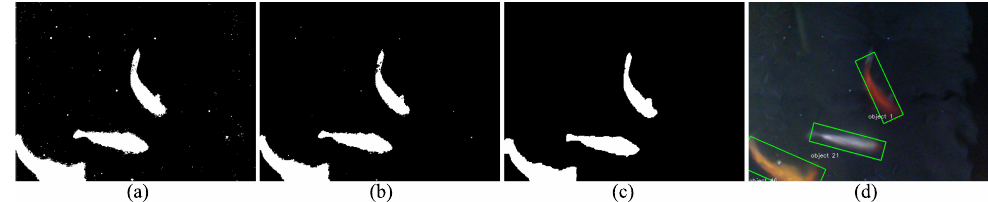
Figure 6. The fish detection process is composed of four stages, as illustrated: ( a ) input image is closed and then opened, ( b ) the closed and opened image is eroded, ( c ) the eroded image is closed, ( d ) final output image with fish detection is obtained.